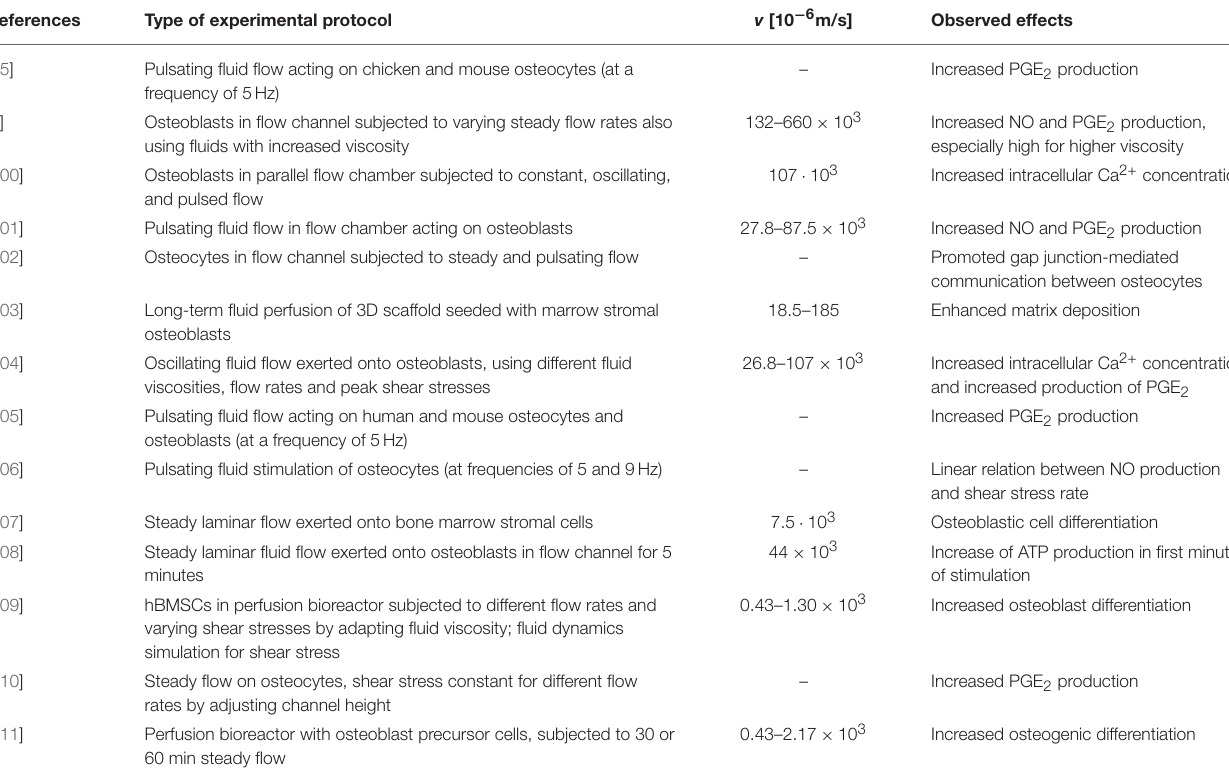
TABLE 1 | In vitro tests showing stimulation of bone cells by fluid flow; studies involving osteocytes neither provide fluid velocities nor provide enough information to back-calculate